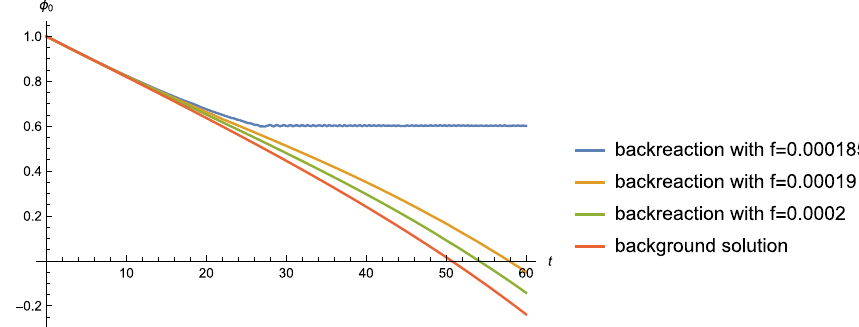
Fig. 2 The evolution of φ 0 for different values of f , with fixed μ = 0 . 1, (cid:5) = 0 . 01, compared with the background solution. Both the field values and the time are in Planck